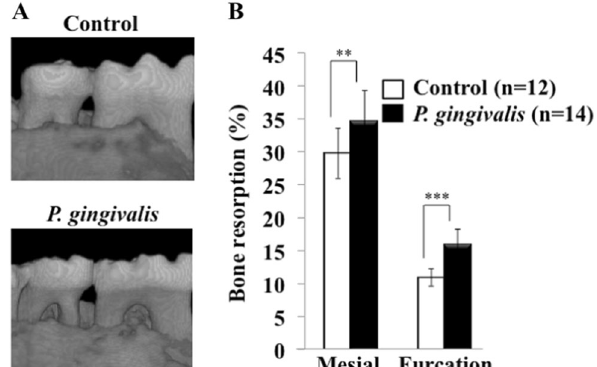
Fig. 1 Evaluation of alveolar bone loss in P. gingivalis -infected APP- Tg mice. a Alveolar bone resorption (imaged by µ-CT). Control: Mice inoculated with CMC alone, P. gingivalis : Mice inoculated with CMC and P. gingivalis . b Alveolar bone resorption was evaluated in the furcation and mesial side of the second molar mandible. Results are expressed as means ± S.D., ** p < 0.01, *** p < 0.001